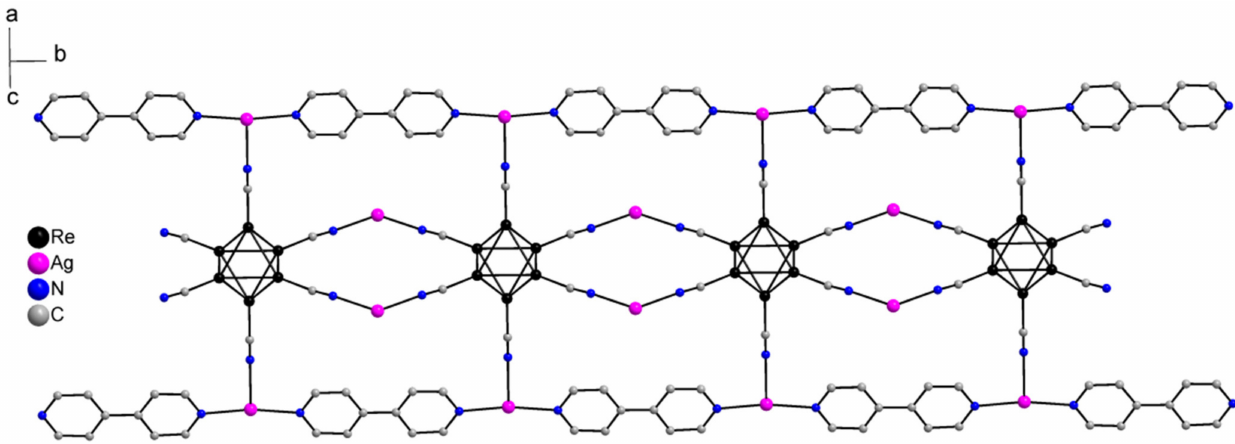
Figure 13. A fragment of the polymeric ribbon compound 4